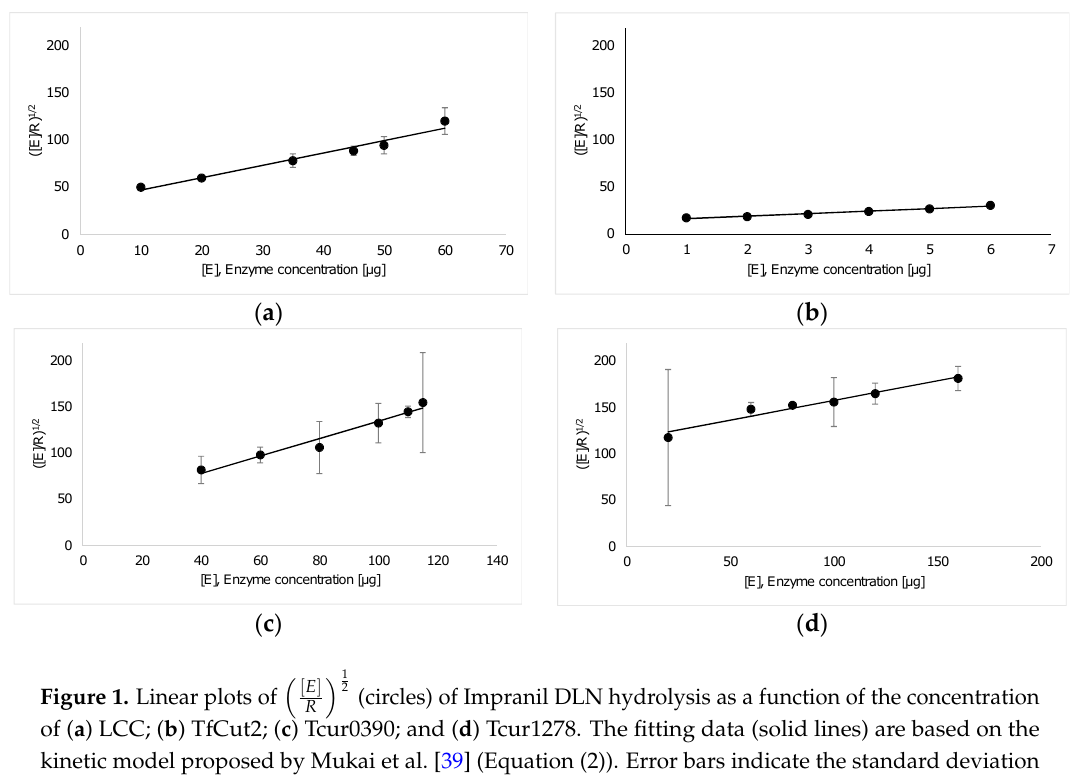
Table 1. Kinetic parameters of the enzymatic hydrolysis of Impranil DLN determined by the kinetic model proposed by Mukai et al. [39] (Equation (2)).